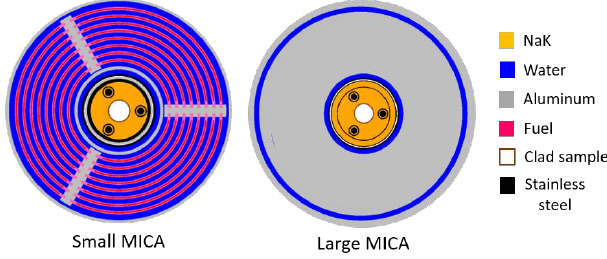
Fig. 2. The MICA test